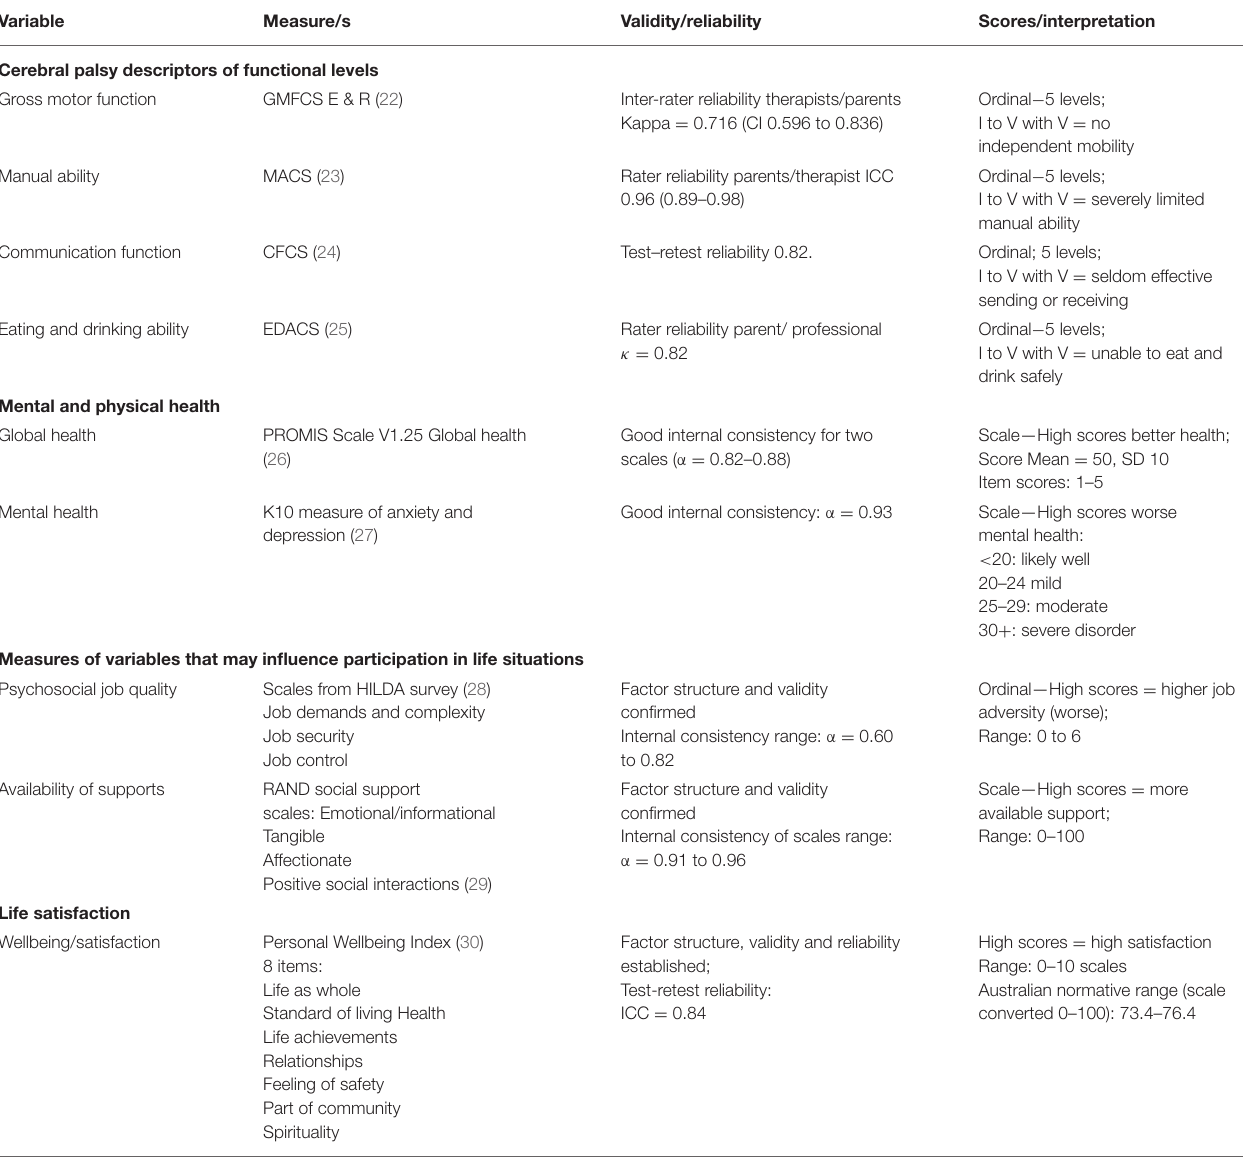
TABLE 1 | Validated measures included in the compiled